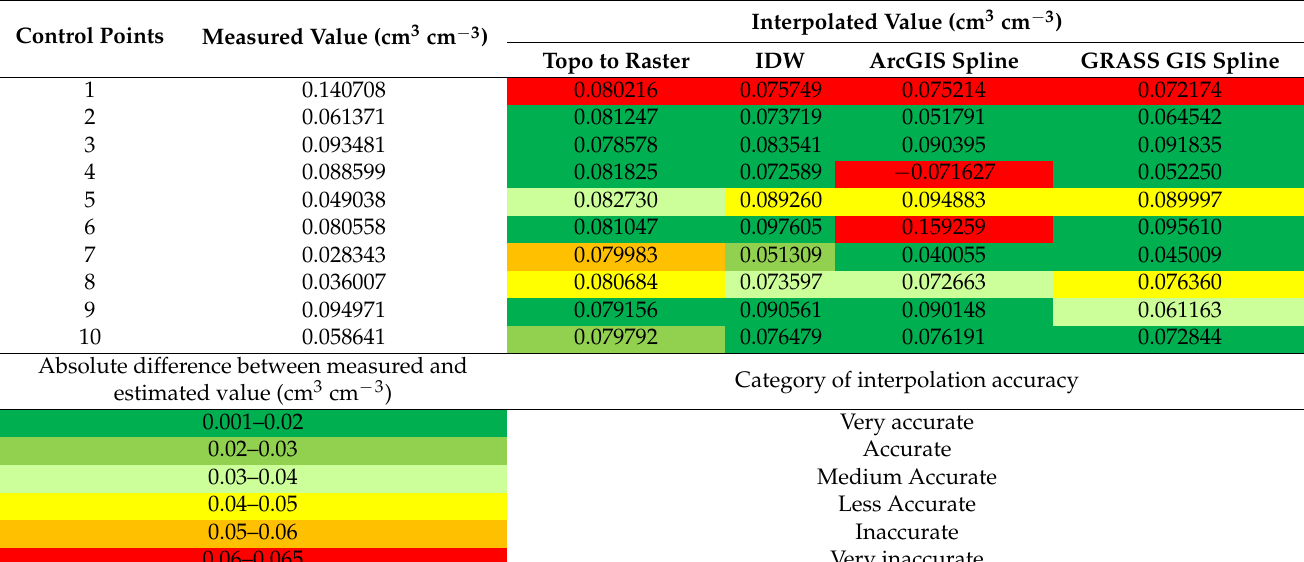
Table 2. Evaluation of the accuracy of available water capacity